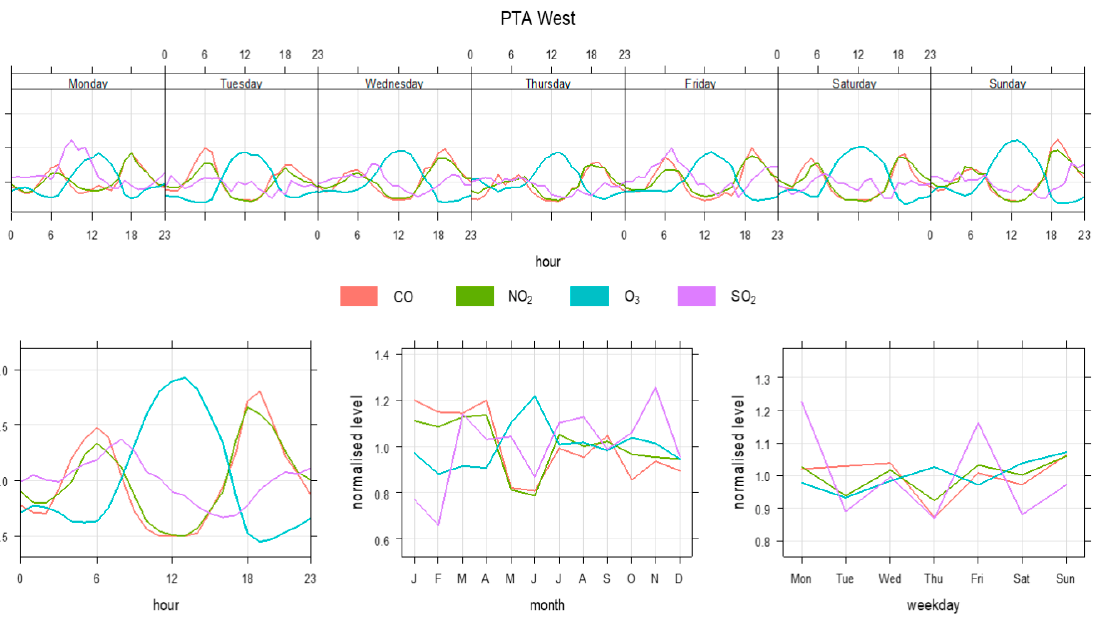
Figure 4. Trends in the concentrations of NO 2 , SO 2, CO, and O 3. *PTA West – Pretoria West Industrial